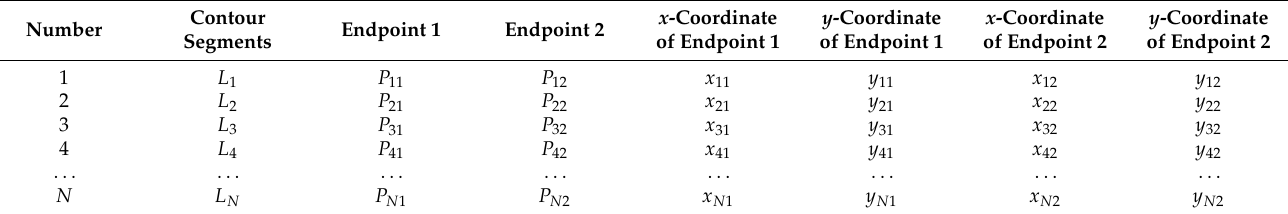
Table 2. Cutting sequence of part contour